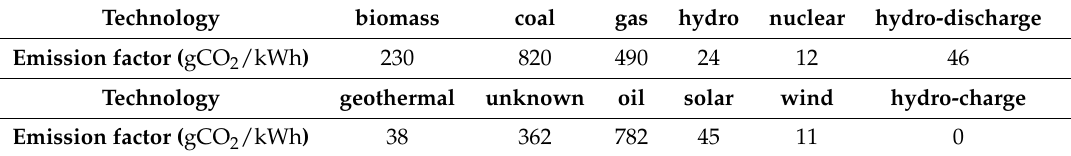
Table A4. Emission factors of different technologies for electricity